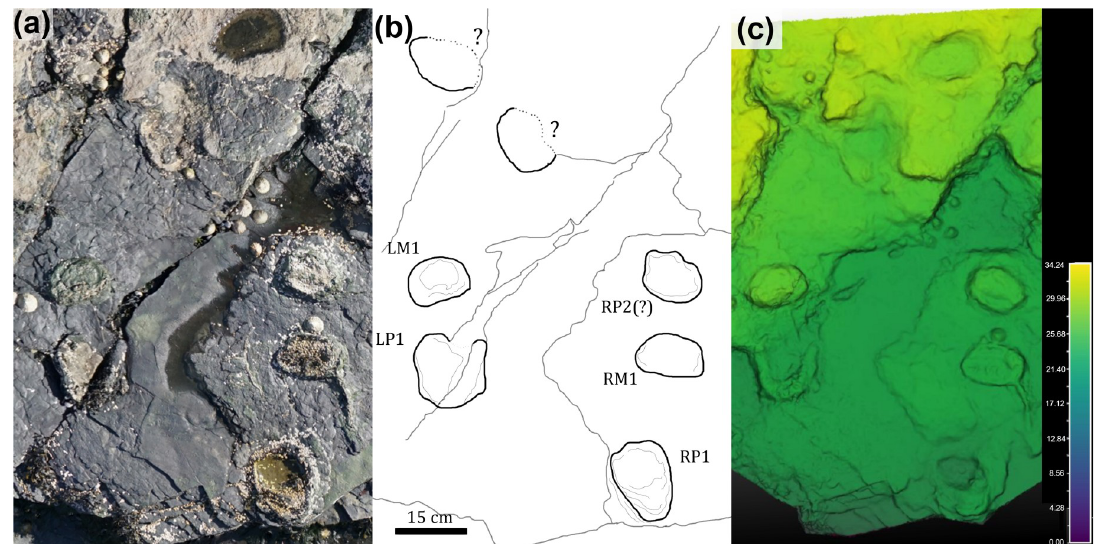
Fig 6. Quadrupedal trackway (BP1_Twy_01) at BP1. The quadrupedal trackway (BP1_Twy_01) shown in an (a) orthophoto from the tracksite photogrammetric model, (b) a line drawing emphasizing distinctive track features, and (c) a false color depth map rendered from the photogrammetric model. Five tracks are clearly associated into the trackway and represent alternating steps with the right manus/pes pair (RM1/RP1) and the left manus/ pes pair (LM1/LP1). Two additional tracks occur immediately above the trackway. However, they are out of line with the trackway progression and their edges are largely obscured by the overlying, light tan limestone layer. Thus, the trackway association is less clear. The color scale of (c) is in units of cm. https://doi.org/10.1371/journal.pone.0229640.g006 defined than digits II and IV. The pes tracks are weakly mesaxonic, elongate, suboval to sub- triangular, and widen anteriorly. The medial and lateral margins of the pes are both nearly straight and the widest point of the pes is located near its anterior margin. The average pes length is ~17 cm and the average width is ~12 cm which yields an average L/W ratio of 1:0.71.